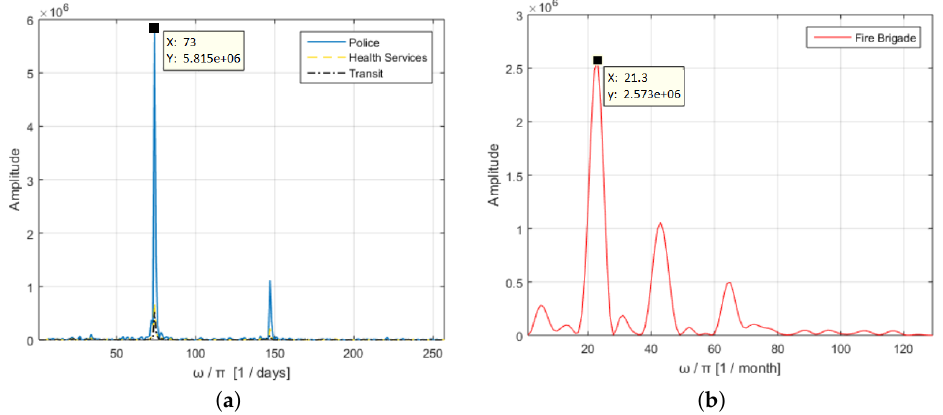
Figure 5. Spectral analysis of short-time periodic institution (STPI) ( a ) and long-term periodic institution (LTPI) ( b ) examples. The narrowband spectrum in both cases and the clear presence of harmonics highlight the periodic and seasonal character of these institutions.